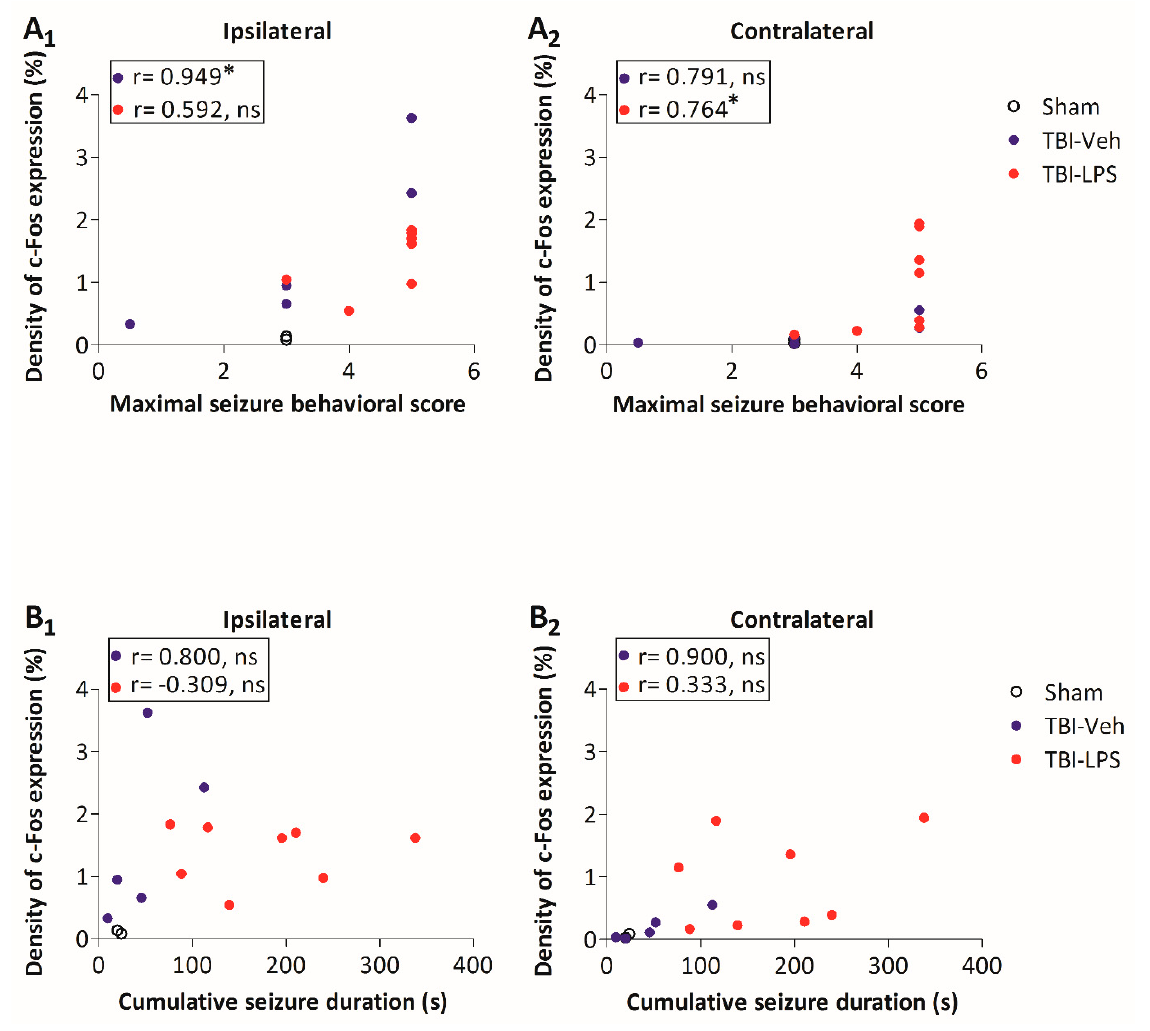
Figure 10. c-Fos expression and seizure susceptibility. Correlations between the density of rostral perilesional c-Fos expression and seizure susceptibility (maximal behavioral seizure score, cumulative seizure duration) in the PTZ-test. ( A 1 ) Ipsilaterally, the higher the density of c-Fos expression, the higher the maximal behavioral seizure score in the TBI-Veh group (r = 0.949, p < 0.05). ( A 2 ) Contralaterally, the higher the c-Fos expression, the higher the maximal behavioral score in the TBI-LPS group (r = 0.764, p < 0.05). No correlations between the density of c-Fos expression and the cumulative seizure duration were detected ( B 1 ) ipsilaterally or ( B 2 ) contralaterally in the TBI-Veh or TBI-LPS groups. Abbreviations: LPS, lipopolysaccharide; ns, non-significant; r, correlation coefficient; TBI, traumatic brain injury; Veh, vehicle. Statistical significances: * p < 0.05 (r, Spearman’s rho correlations).